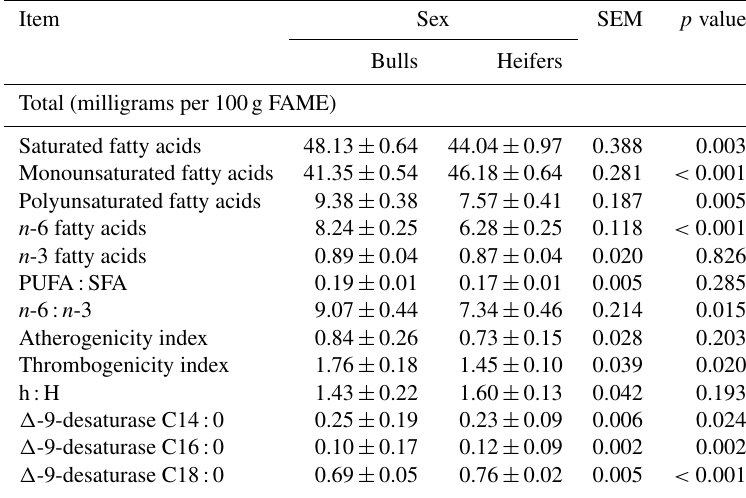
Mean ± standard deviation; p values were considered significant at 0.05. Table 4. Total and nutritional quality indexes and desaturase indexes of the Longissimus lumborum muscle of feedlot cattle finished with a whole shelled corn